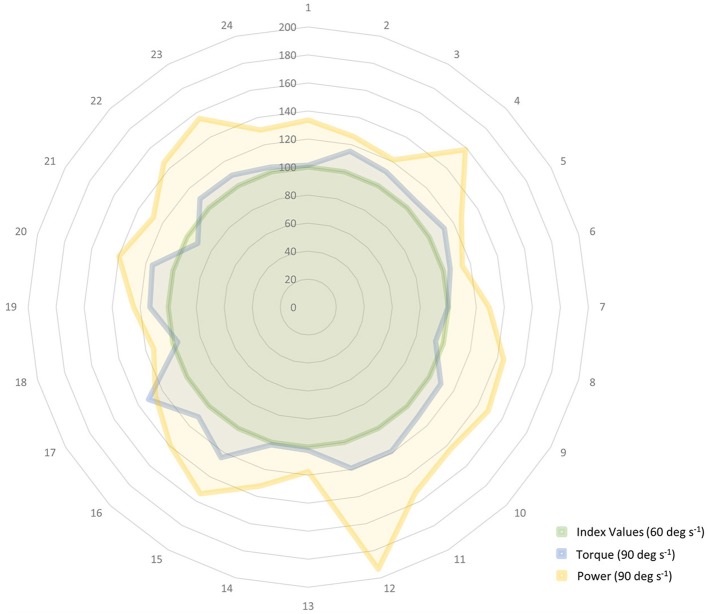
Relative change in eccentric peak torque and mean power while using a fixed workload target during 60 and 90° s−1 isokinetic knee extension exercise. The velocity-dependent behavior in eccentric torque and power generation are depicted in the radar graph. Torque and power data are indexed to the values obtained during the 60° s−1 condition (e.g., 100%, as shown in the innermost circle and centerline values) and the participant identification numbers are listed along the periphery of the circle. The participants used the same workload targets during exercise at both isokinetic speeds. The data attained during the 90° s−1 condition show that the attained peak torque values were comparable to those recorded during the 60° s−1 condition (Δ 7%). However, a greater proportional difference in mean power generation was noted in the 90° s−1 condition in comparison to the 60° s−1 condition (Δ 25%) within the sample. (deg, degrees; s, seconds).